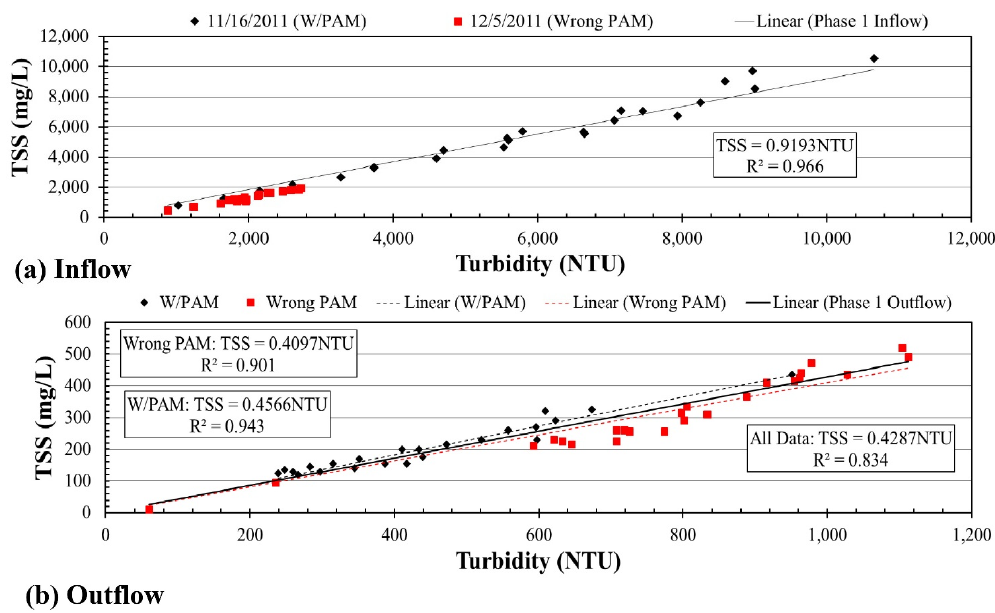
Figure 4. Total suspended solids (TSS) and turbidity correlations for the two data sets in Phase I: Different scales used in ( a ) and ( b ) for x and y